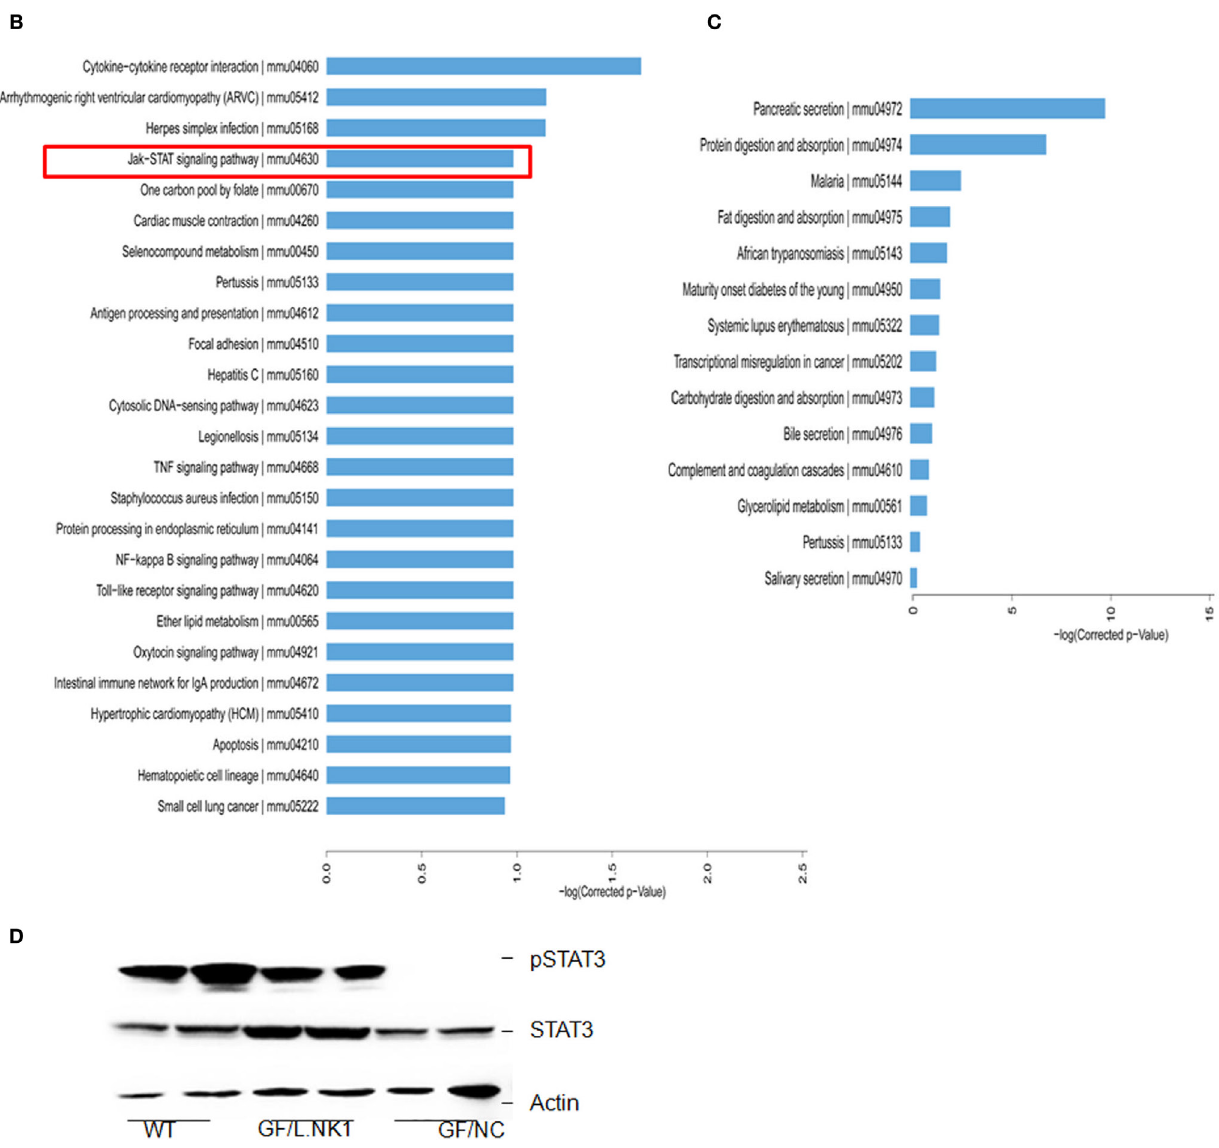
FigUre 3 | STAT3 is activated in the gut immune tissues of lactobacillus NK318.1 -colonized GF mice. (a) Circos analyses of gene expression in the Payer’s patch of GF mice with (L.NK.1) or without Lactobacillus NK318.1 (L.NC) colonization (pooled samples; n = 6). See also microarray GEO accession number GSE98819: https://www.ncbi.nlm.nih.gov/geo/query/acc.cgi?acc = GSE98819. (B) Enriched KEGG pathways of differentially expressed genes in the Payer’s patch of GF mice with (L.NK.1) or without Lactobacillus NK318.1 (L. NC) colonization (pooled samples; n = 6). (c) Enriched KEGG pathways of differentially expressed genes in the ileum epithelial cells of GF mice with (L.NK.1)or without Lactobacillus NK318.1 (L. NC) colonization (pooled samples; n = 6). (D) Immunoblotting of phosphor-STAT3 in the ileum lamina propria tissues of GF mice with (GF/L.NK1) or without (GF/NC) Lactobacillus NK318.1 colonization. WT, wild-type; GF, germ